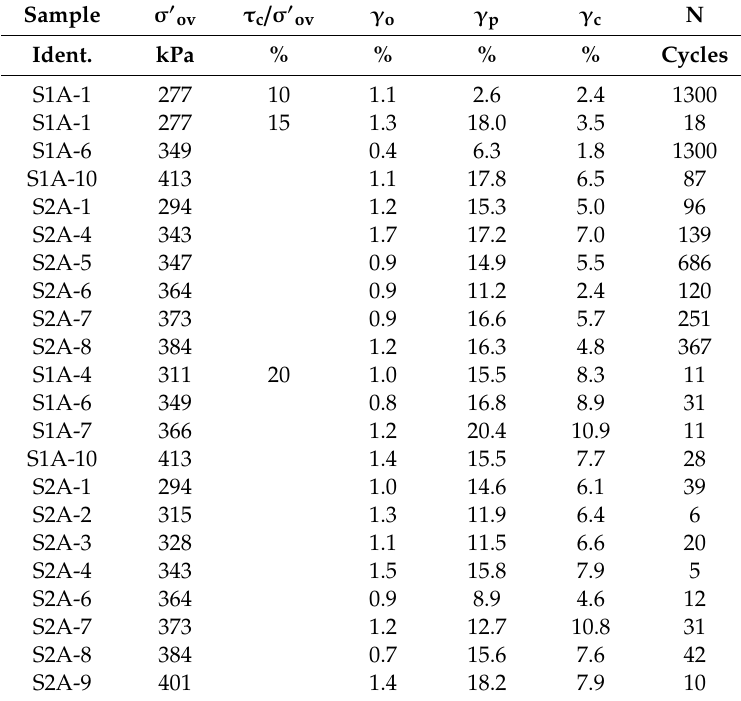
Table 6. Results of cyclic simple shear test with τ o / σ (cid:48) ov =